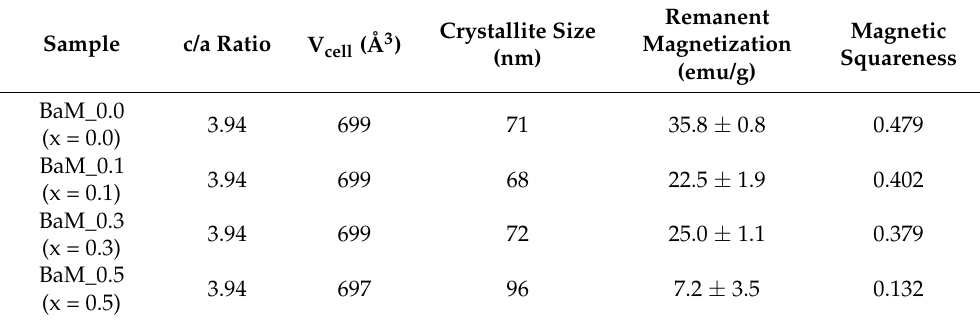
Figure 1. XRD spectra of BaFe 12 − x Cu x O 19 (x = 0, 0.1, 0.3, and 0.5) compared to a standard profile of barium hexaferrite (JCPDS: 43-0002). Table 1. Comparison of structural parameters from XRD, remanent magnetization, and magnetic squareness from VSM of BaFe 12 − x Cu x O 19